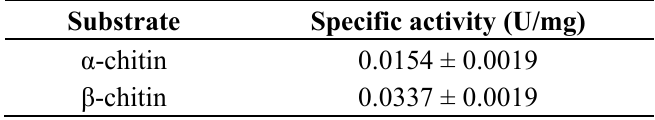
Table 2. Specific activity of pancreatin for degrading different types of